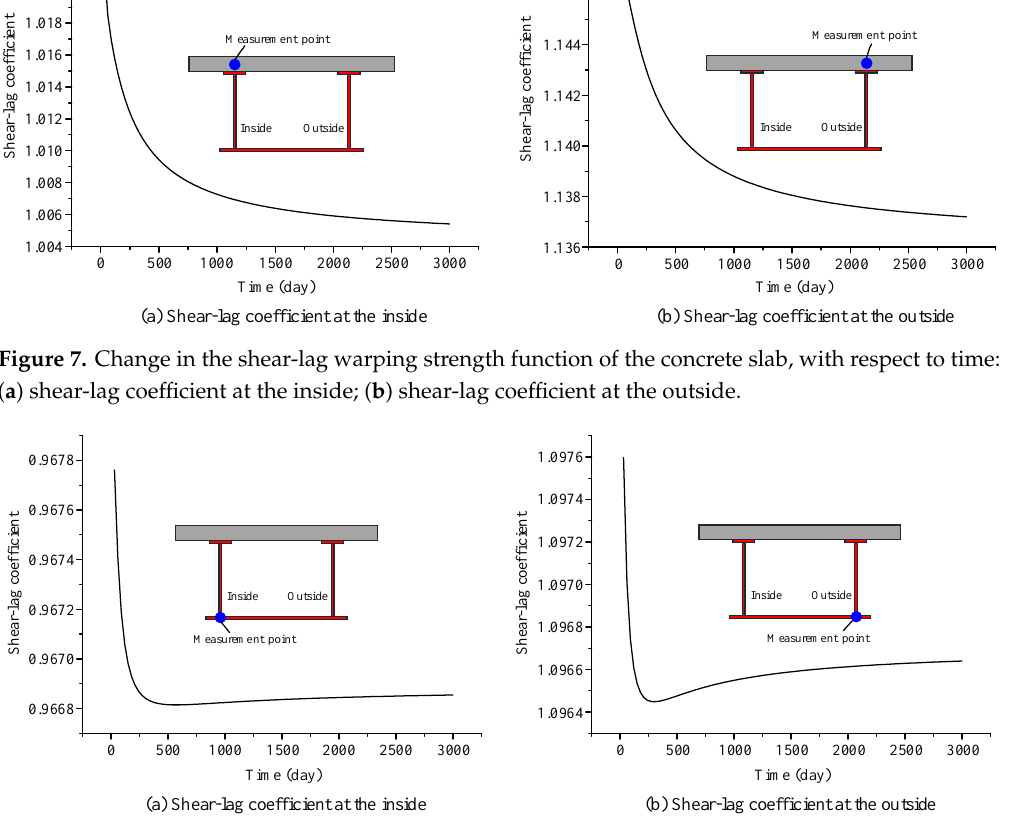
Figure 8. Change in the shear-lag warping strength function of the steel bottom flange, with respect to time: ( a ) shear-lag coefficient at the inside, ( b ) shear-lag coefficient at the outside.